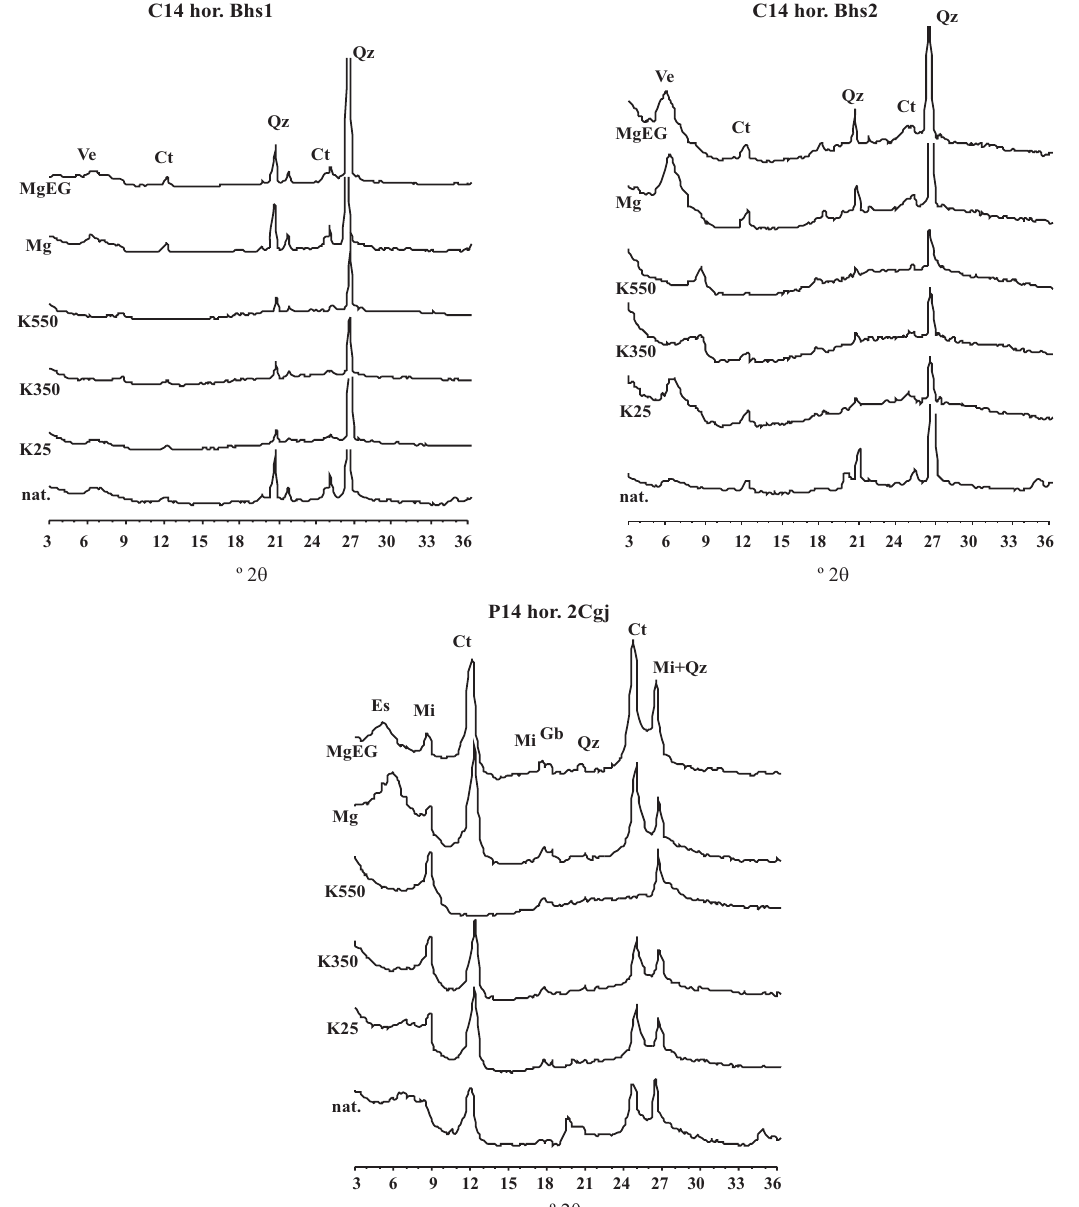
Figura 5. Difratogramas dos horizontes Bhs1 e Bhs2 do perfil C14 e do horizonte 2Cgj do perfil P14. Ct: caulinita, Mi: mica, Qz: quartzo, Gb: gibbsita, Es: esmectita, Ve: